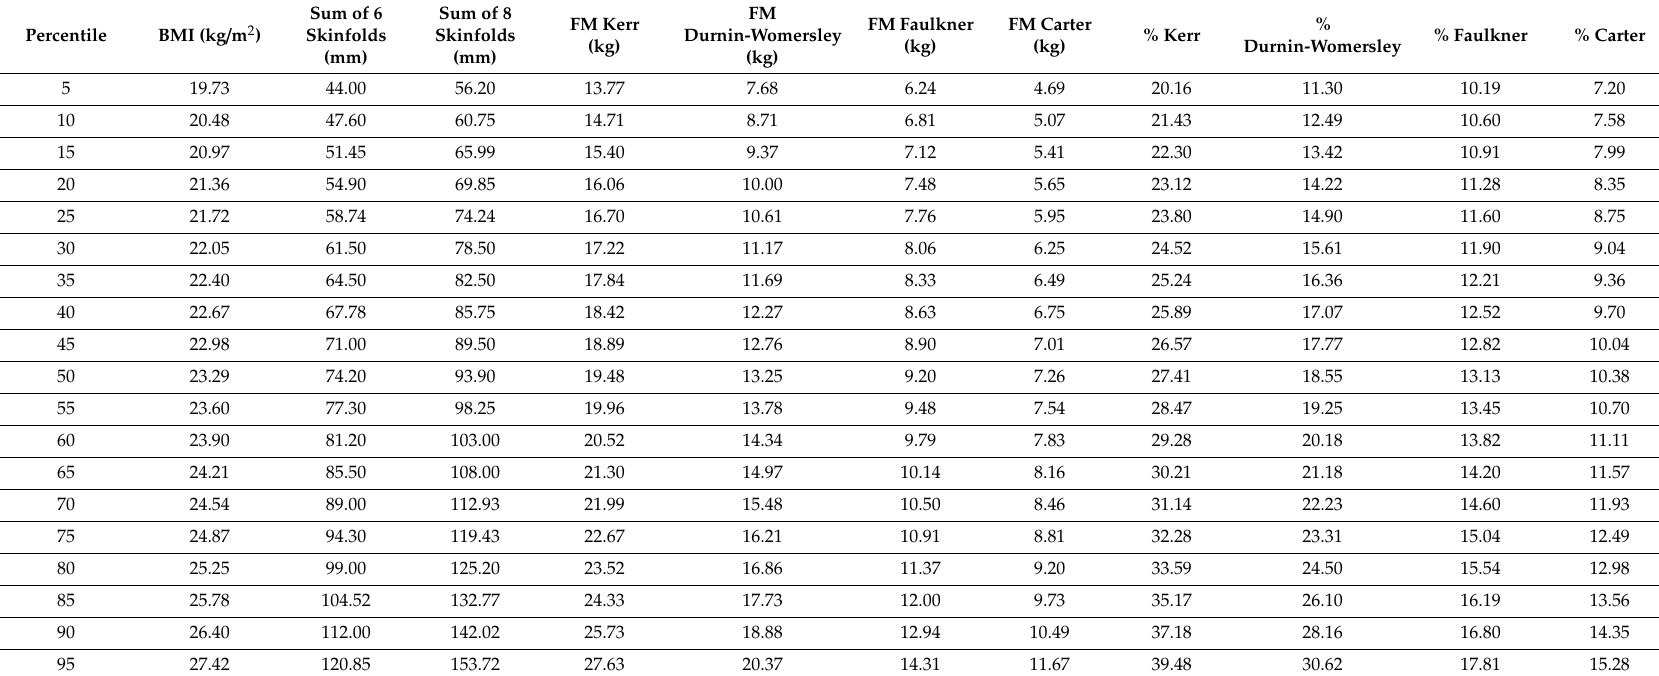
Table 6. Percentile relationship of the sums of skinfolds and the kilograms and percentage